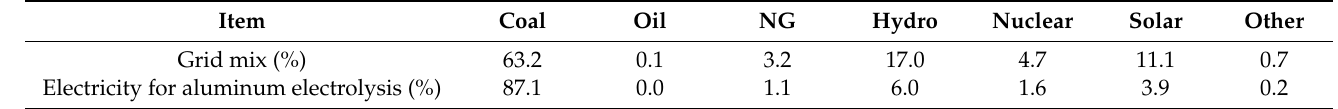
Table 3. Nationwide sources of electricity generation for the grid mix and electrolytic aluminum mix.